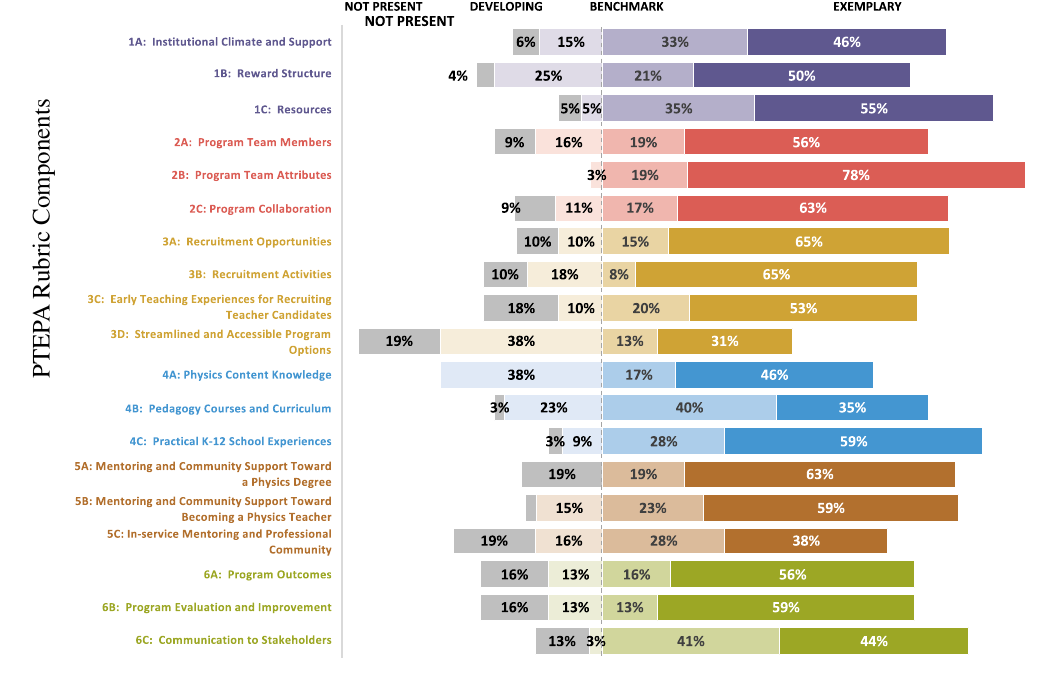
FIG. 3. Percent of items rated at each level across all eight studied programs, by component. From the left are shown not present (gray), developing (light shaded), benchmark (medium shaded), and exemplary (dark shaded). Percentages are out of the number available ratings per component (No. of items/component × 8